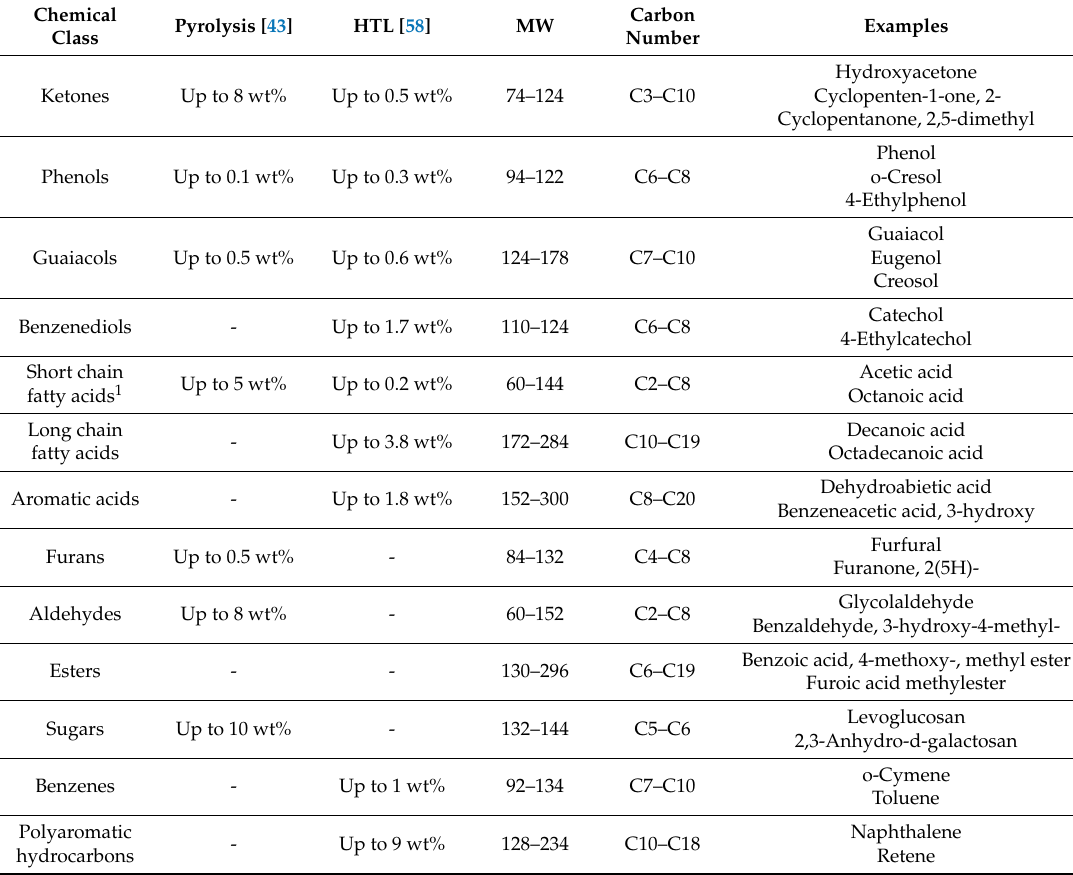
Table 5. Typical chemical classes identified by gas-chromatography coupled with mass spectrometry (GC-MS) in bio-oils with examples of mass fractions in pyrolysis oils and HTL biocrudes from pinewood and examples of specific components [10,43,57,58,76,81–84]. MW, molecular